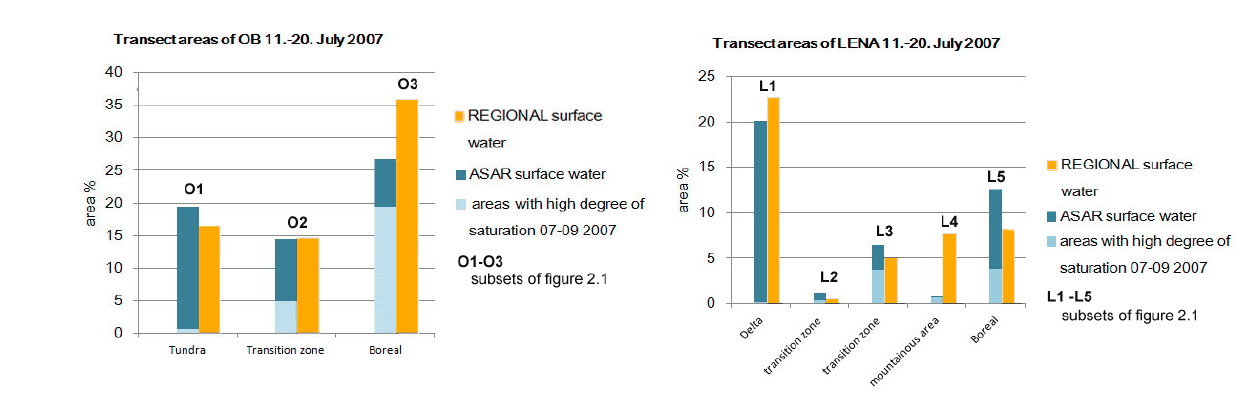
Figure 9. Comparison of h S area (light blue) and open water bodies area (dark blue) W derived from ASAR WS data statistics with the area of the regional wetland product (red) in different landscape types of Ob and Lena region. The dynamics of total wetland areas are comparable in most regions. The location of the transects are shown in Figure